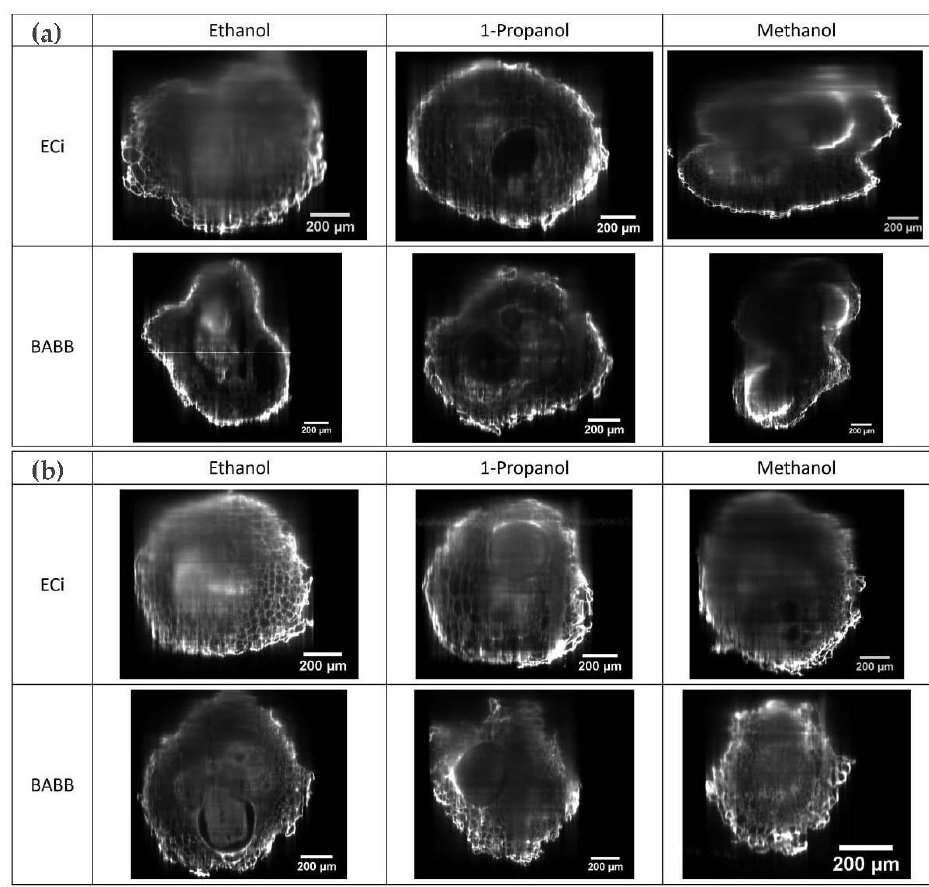
Figure 3. Comparative study of LSFM penetration depth, for different dehydration (ethanol, 1-propanol and methanol) and clearing agents (ECi and BABB), in ( a ) tomato and ( b ) eggplant galled root samples. The cross-section along the XZ plane allows comparing and evaluating the degree of penetration and image quality distortion obtained in each clearing protocol. The lower part of the images corresponds to the closest to the camera. Scale bar: 200 µm.